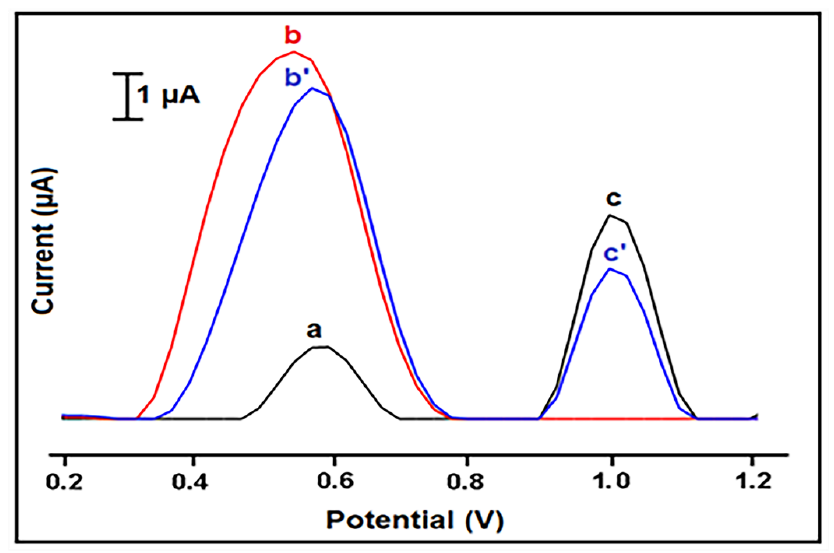
Figure 6. Voltammograms representing the oxidation signal of 10 µ g/mL curcumin and the oxidation signal (i.e., guanine signal) of 25 µ g/mL PCR sample measured before and after 3 min interaction: (a) the control signal measured by HaP-IL-PGE, oxidation signal of curcumin (b) before, (b’) after interaction, oxidation signal of guanine (c) before, and (c’) after